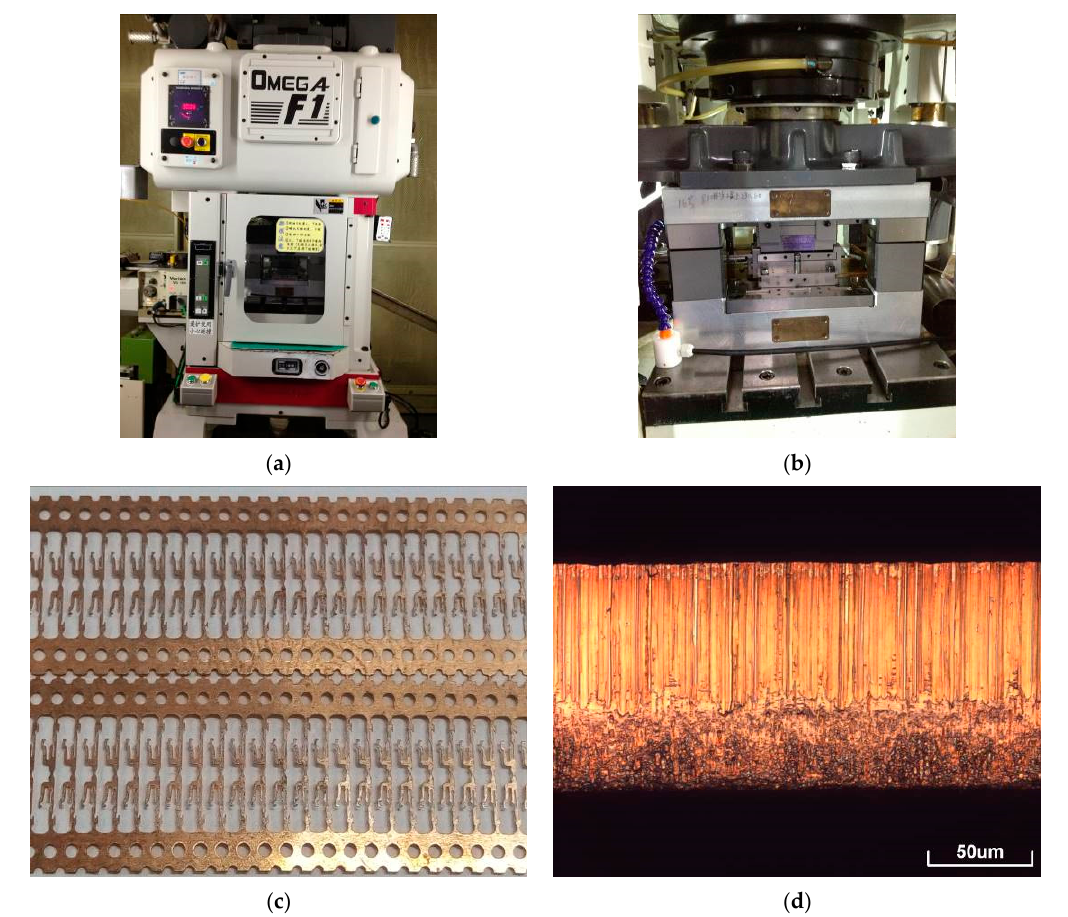
Figure 1. Ultra-high-speed punching press and ultra-high-speed precise progressive stamping die. ( a ) DOBBY-OMEGA F1 ultra-high-speed punching press; ( b ) Ultra-high-speed precise progressive blanking die; ( c ) Thin sheet strips after ultra-high-speed blanking; ( d ) Morphology of thin sheet blanked edge after ultra-high-speed blanking.